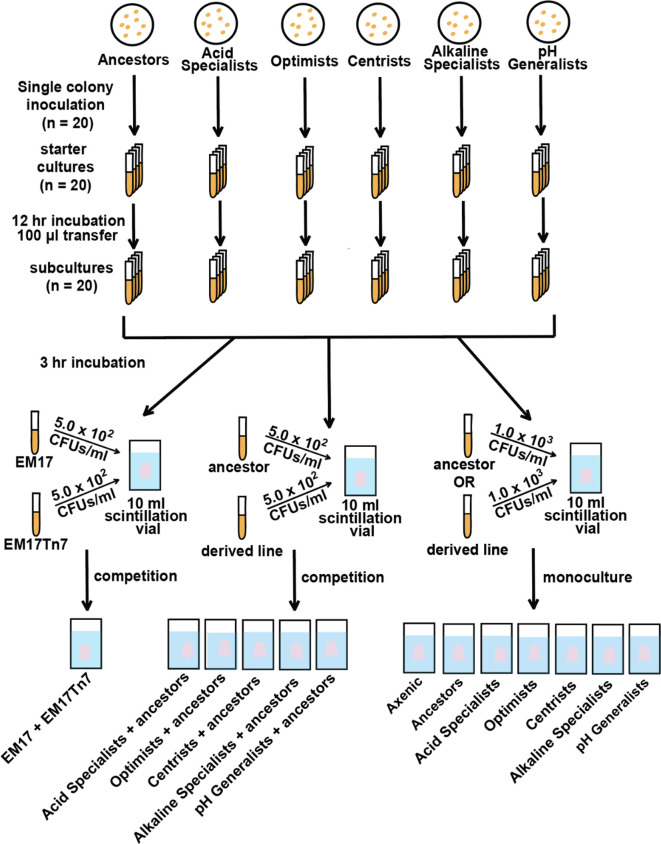
The 
V. fischeri
 ancestors and derived lines were grown and used to inoculate the squid hosts for monocultural and competition studies. Bioluminescence data was collected from the monoculture studies. Axenic (uninoculated) animals served as negative controls.